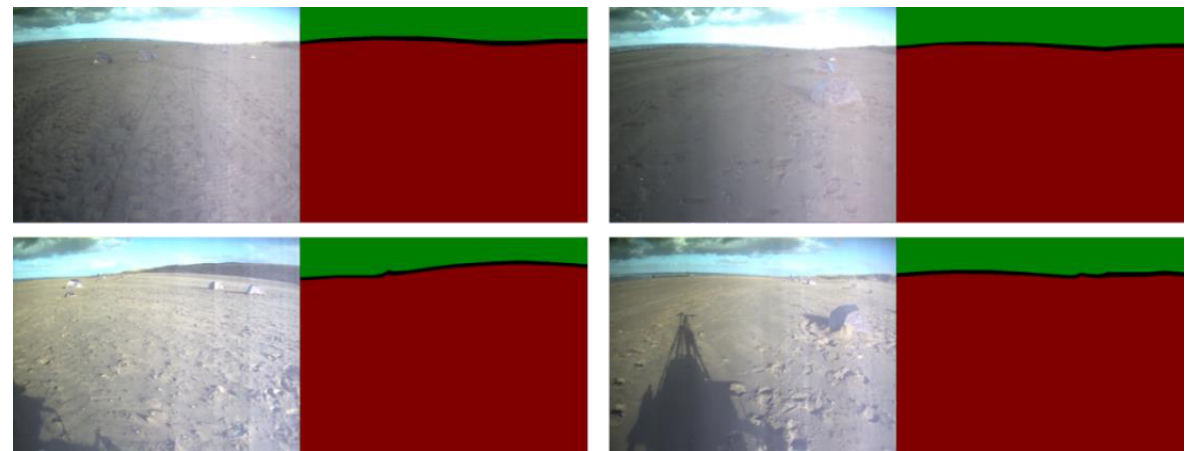
Figure 12. The conservative labels for the navigation visions of the planetary rover. The red, green, and black regions refer to the ground, sky, and un-annotated pixels, respectively. The left figures come from the Katwijk dataset [47]. Table 3. The experimental results of the transfer learned NI-U-Net.